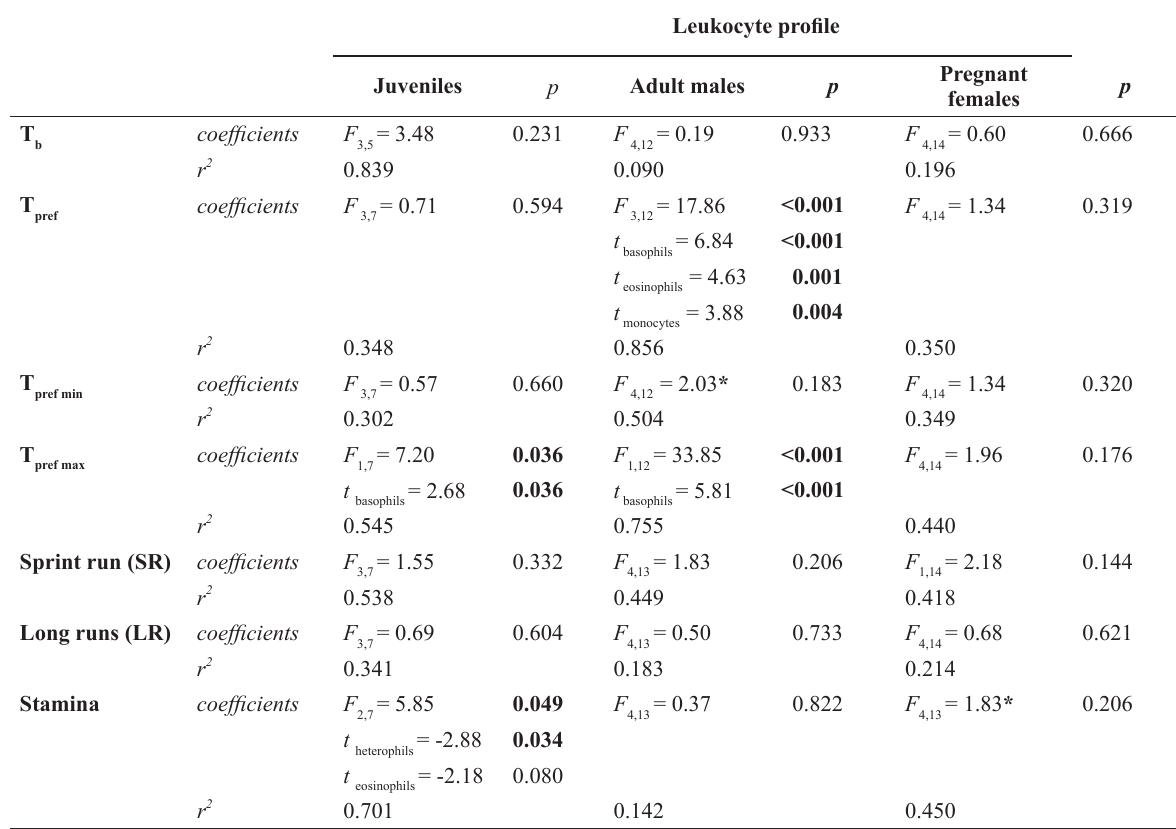
Figure 2 - Significant relationships in the regression analyses among variables related with thermoregulation: mean ) preferred body temperature versus percentages of basophils (●) of Liolaemus sarmientoi . maximum value (T pref max Linear regression (solid line) and their 95% confidence intervals (dashed lines) of T versus basophils in juveniles pref max ( a ) and adult males ( b ). Multiple Regression Stepwise of body temperature (T , ºC), preferred body temperature (T ; °C), minimum preferred b pref body temperature (T ; °C), maximum preferred body temperature (T ; °C), short run (SR; m/s), long run (LR; pref-min pref-max m/s), and locomotor stamina (s) versus leukocyte profile of juveniles, adult males, and pregnant females. Regression coefficients, correlation coefficient ( r 2 ), and p values are indicated. The asterisk (*) indicates when residuals between the snout-vent length (SVL) and T or stamina were used. Significant p values are indicated in pref min